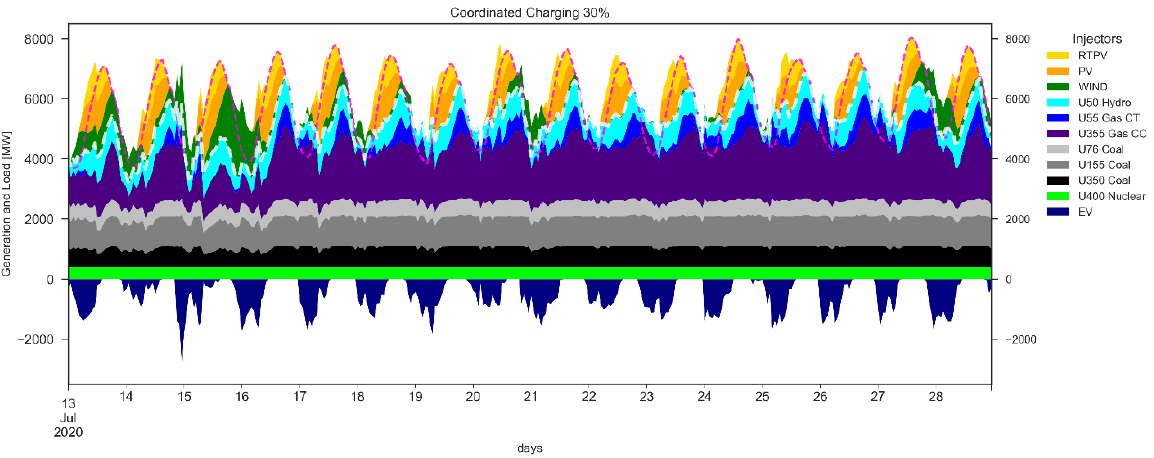
Figure 15. The generation stack for peak weeks in July, assuming 30% EV penetration and coordinated EV charging. EV